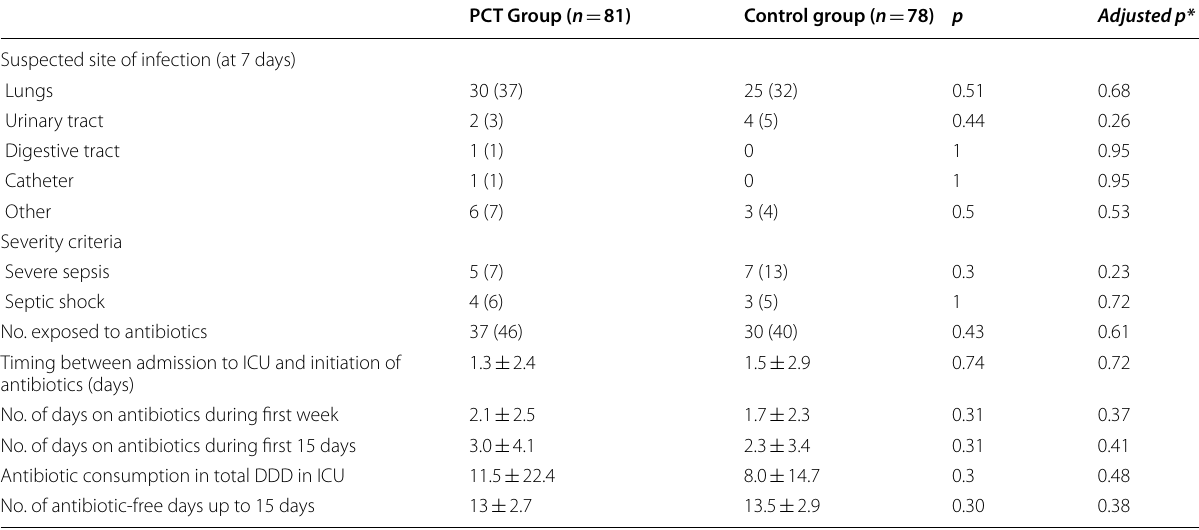
Table 2 Details of infections and antibiotic